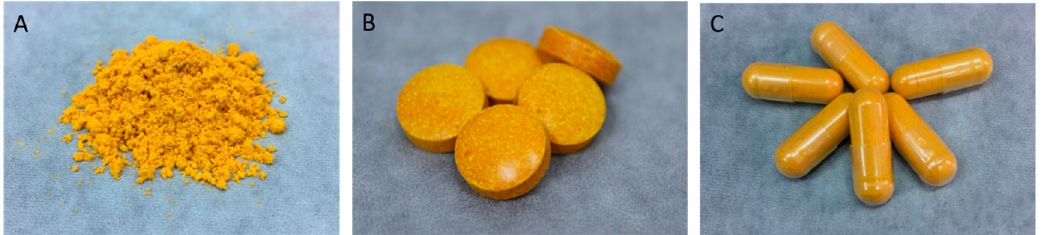
Figure 7. Pharmaceutical formulations of curcumin-loaded solid self-assembled micelles (Cur-SM). ( A ) Cur-SM powder, ( B ) tablet formulation of Cur-SM, and ( C ) capsule formulation of Cur-SM.